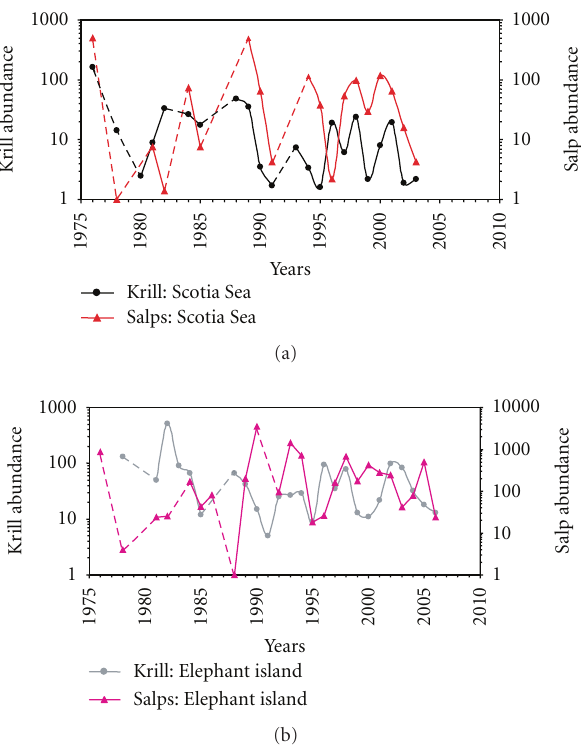
Figure 13: Long-term variability of Antarctic krill and salp densities (ind.m − 2 in the Scotia Sea (a) and ind.1000 − 3 around Elephant Island (b)) in the Atlantic sector of the Southern